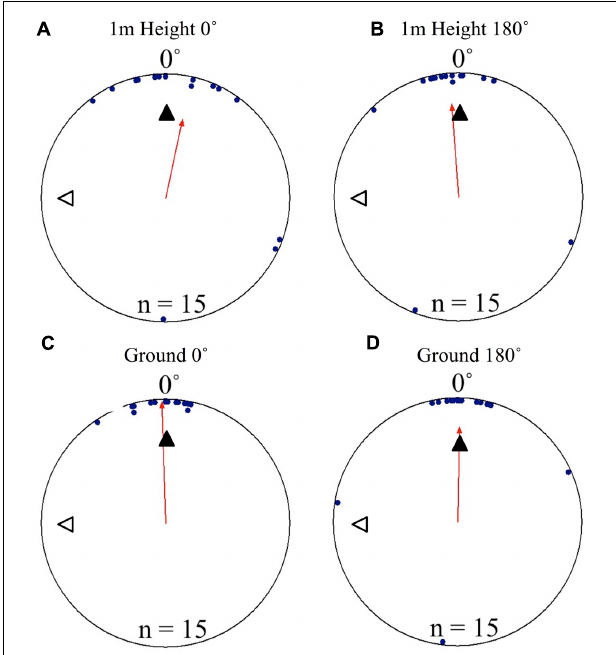
FIGURE 3 | Circular distributions of individual M. midas foragers’ positions on the tree face during displacement experiments with cue conflicts. Figures show the raw data of forager positions at two heights after displacements to one of two sides of the tree at a 1.5 m height at Nest 3. The nest direction for each figure is at 0 ◦ , labelled by a black triangle. The foragers’ accumulated vector was at 270 ◦ , labelled by a white triangle. The arrow denotes the direction and length of the mean vector. Foragers were collected at the base of their foraging tree, held overnight and then released vertically on the tree face of the nest tree at one of two sites (0 and 180 ◦ ). (A) The position of individual foragers released at the 0 ◦ location at 1 m in height. (B) Forager position at Nest 1 of individuals released at the 180 ◦ location at 1 m in height. (C) The position of individual foragers released at the 0 ◦ location as they reach the ground. (D) The position of individual foragers released at the 180 ◦ location as they reach the ground. FIGURE 4 | Circular distributions of individual M. midas nest tree foragers’